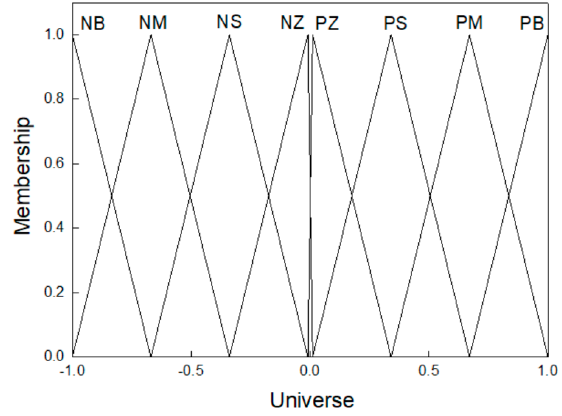
Figure 7. Fuzzy set definitions.